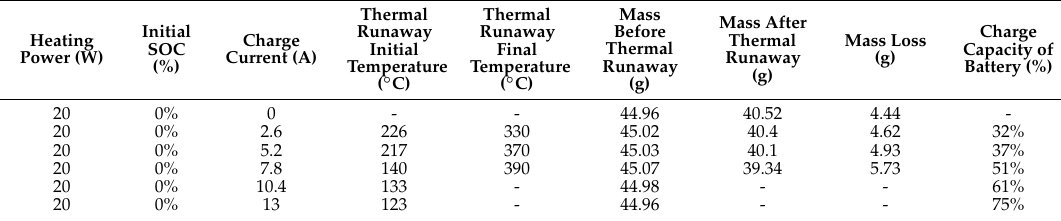
Table 4. Experimental results of lithium-ion battery under different charging